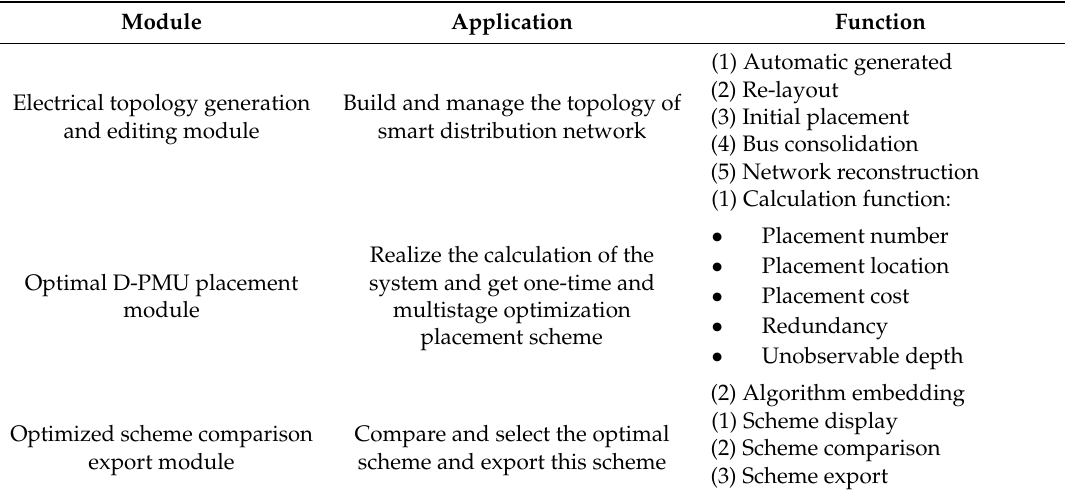
Table 1. System module function